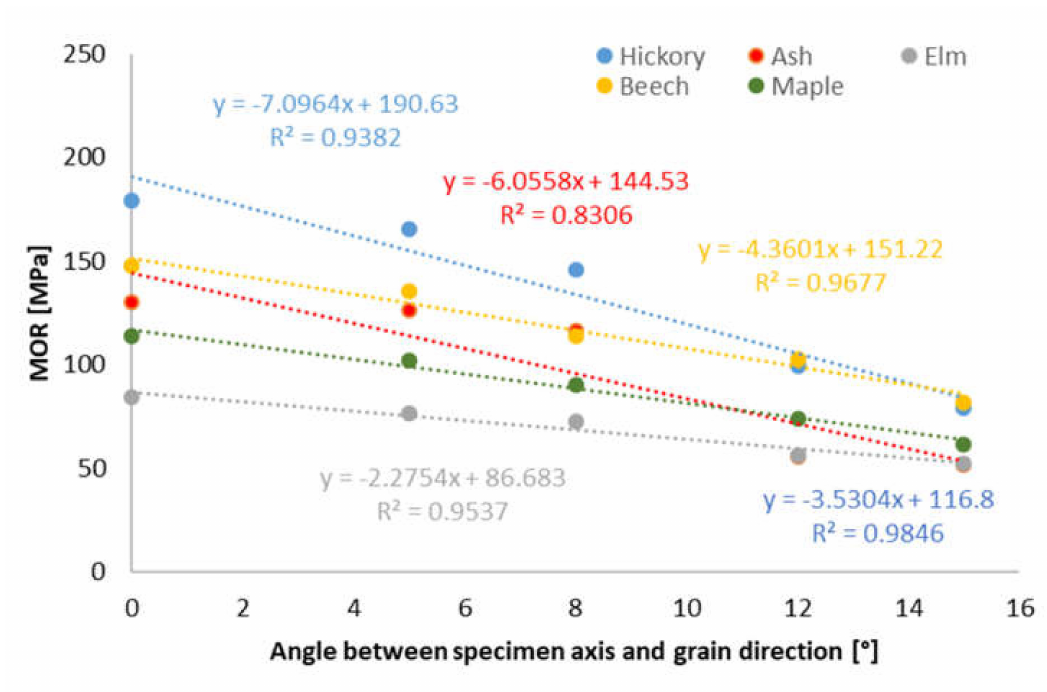
Figure 2. E ff ect of the slope of grain on the modulus of rupture